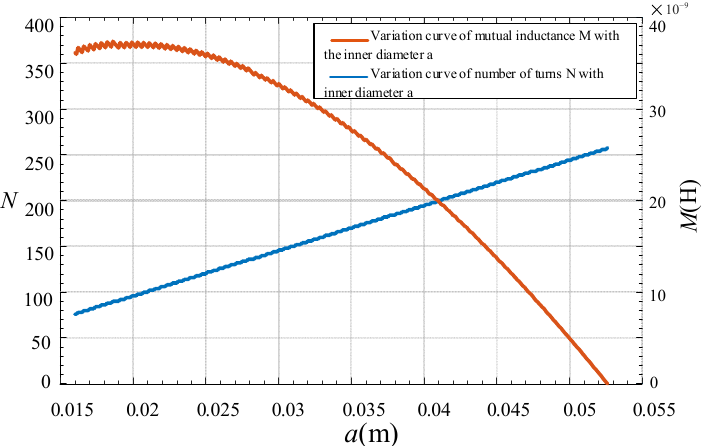
Figure 9. Variation curve of coil turns and mutual inductance with inner diameter when the outer diameter of the coil is fixed.